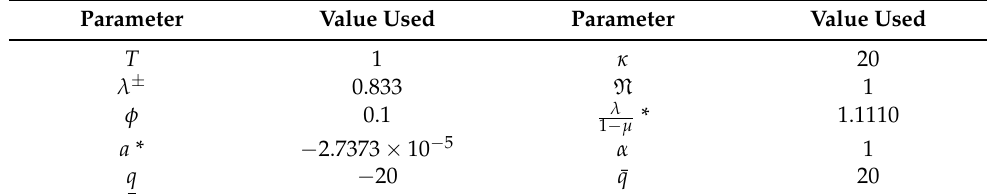
Table 9. Market-making parameters for Amazon stock.